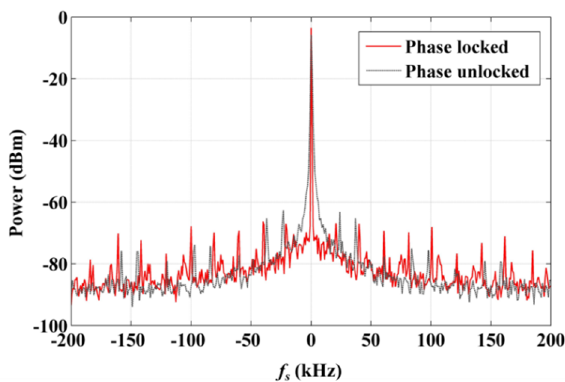
Figure 6. Spectra of EFL and UCL beat signal obtained using OPLL, with phase locking and without phase locking.